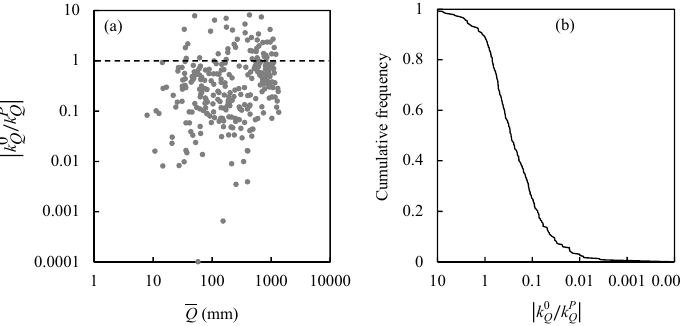
Figure 9. Analysis of the controlling factor in the DDWW pattern according to the Budyko hypothesis. (a) Relationship between the ratio of absolute k 0 ( = ε 0 k E , the part of the estimated runoff trends k Q Q p ( = ε P k P , the part of k Q generated from precipitation changes) and the mean annual runoff Q . (b) Cumulative frequency curve of | k 0 e